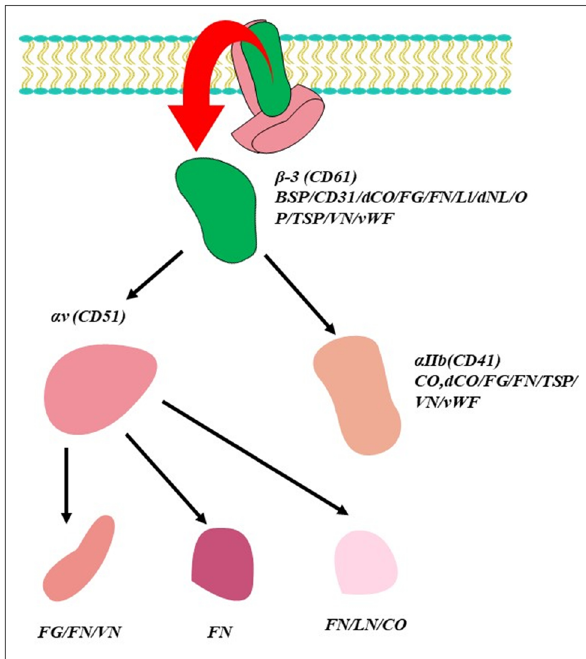
Figure 2: Integrin α – β heterodimers identi fi ed and grouped according to the broad families, and the ligands bound by the hetero - dimer are presented in italics either under α subunit, β subunit, or adjacent to the αβ pair. Ligands BSP, bone sialoprotein; CD31, cluster of di ff erentiation antigen 31; CO, collagens; dCO, denatured col - lagens; FG, fi brinogen; FN, fi bronectin; L1, cell adhesion molecule; LN, laminins; dLN, denatured laminin; OP, osteopontin; TN, tenascin; TSP - 1, thrombospondin; VN, vitronectin; vWF, von Willebrand fac. The ligands are listed in alphabetical order and are not presented as a major ligand for any of the